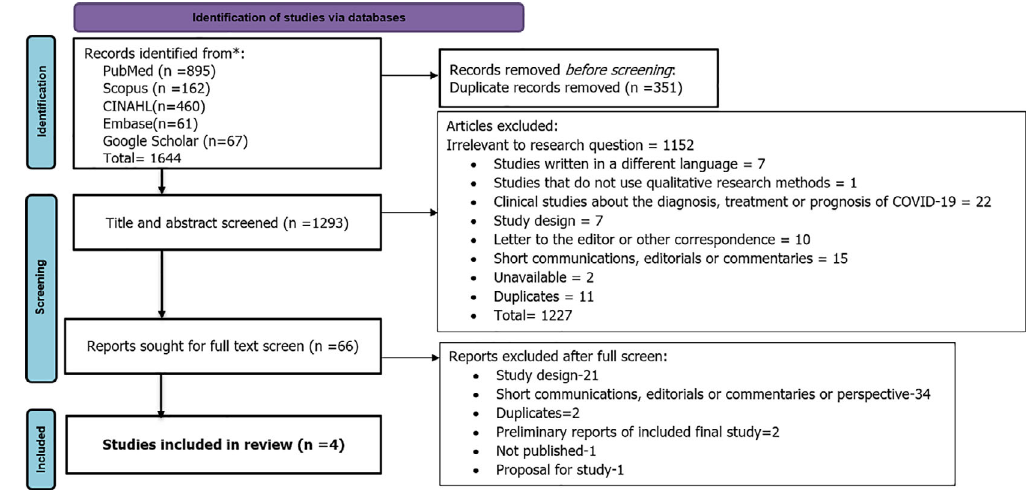
Figure 1. Preferred Reporting Items for Systematic Reviews and Meta-Analyses (PRISMA) flow